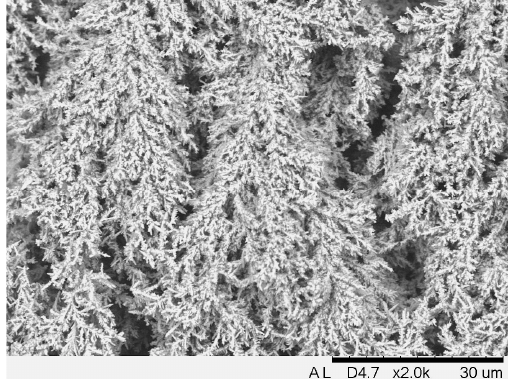
Figure 9. SEM image of electrodeposit obtained at E = − 0.6 V and 60 °C from the solution “L2”.